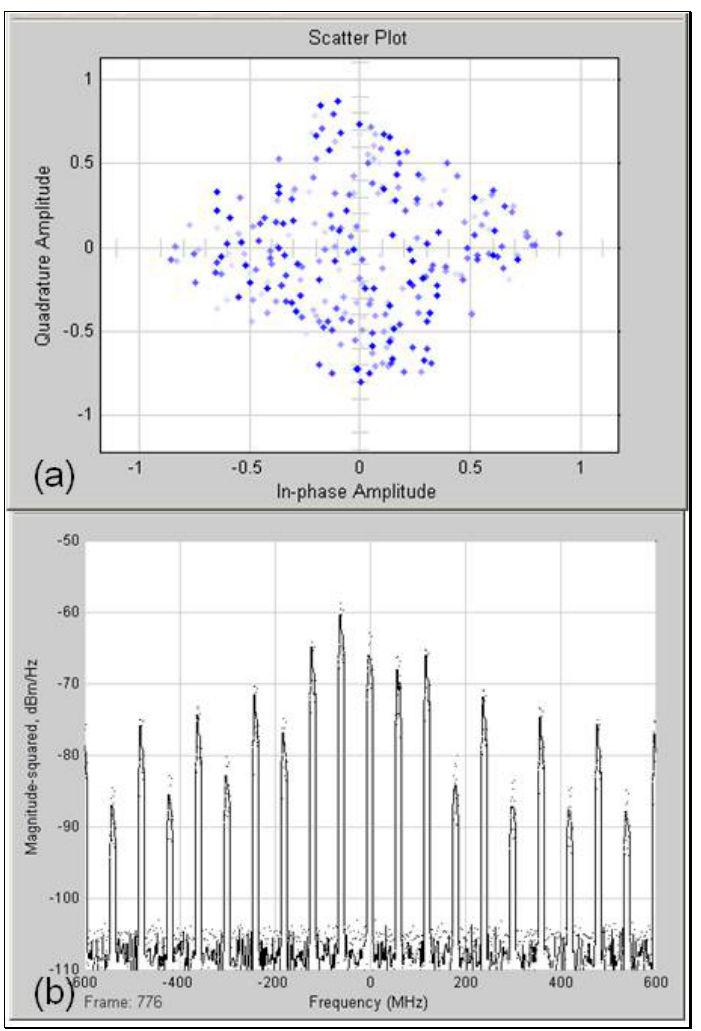
Figure 10. ( a ) Constellation, and ( b ) spectrum of the composite received signal of all OAM modes before demodulator (shifted by 0 Hz in this case).